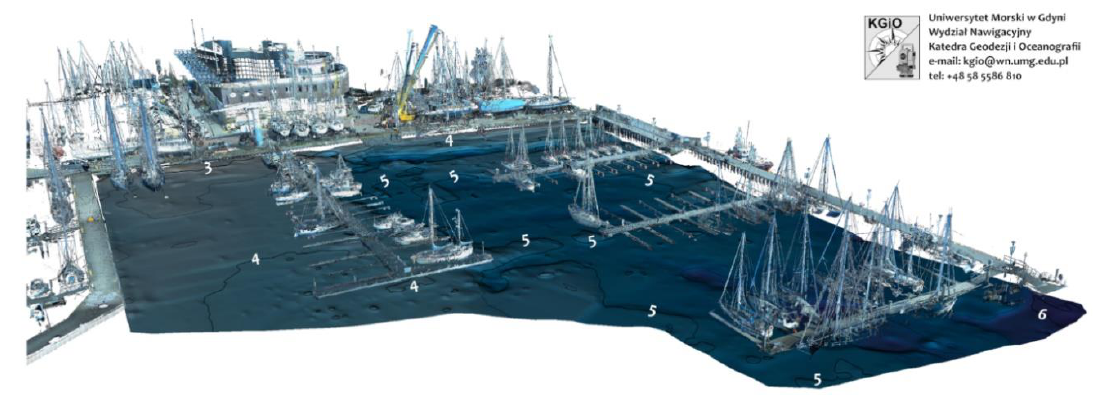
Figure 13. Synthesis of geospatial data from bathymetric sounding and laser scanning.